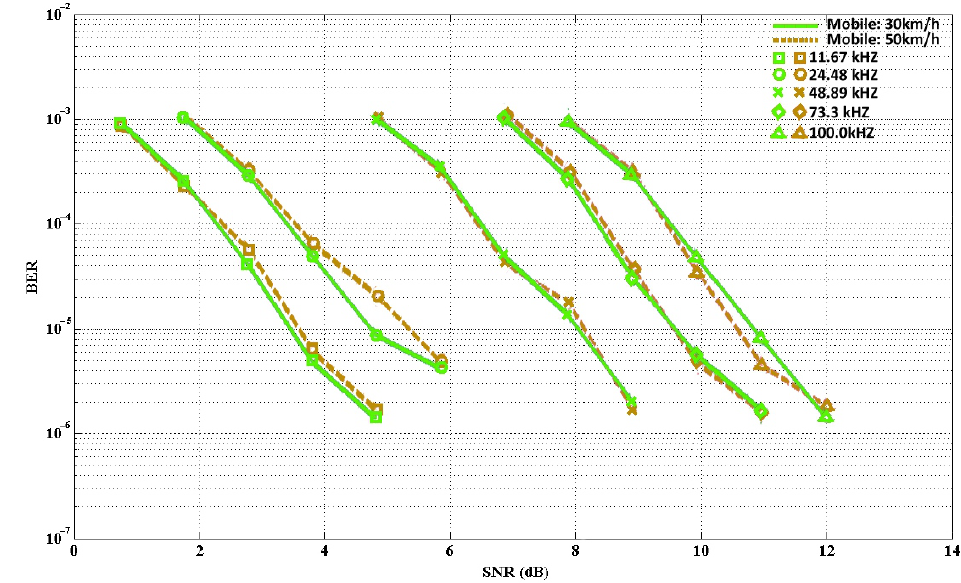
Figure 9. BER for several frequencies (mobile conditions).